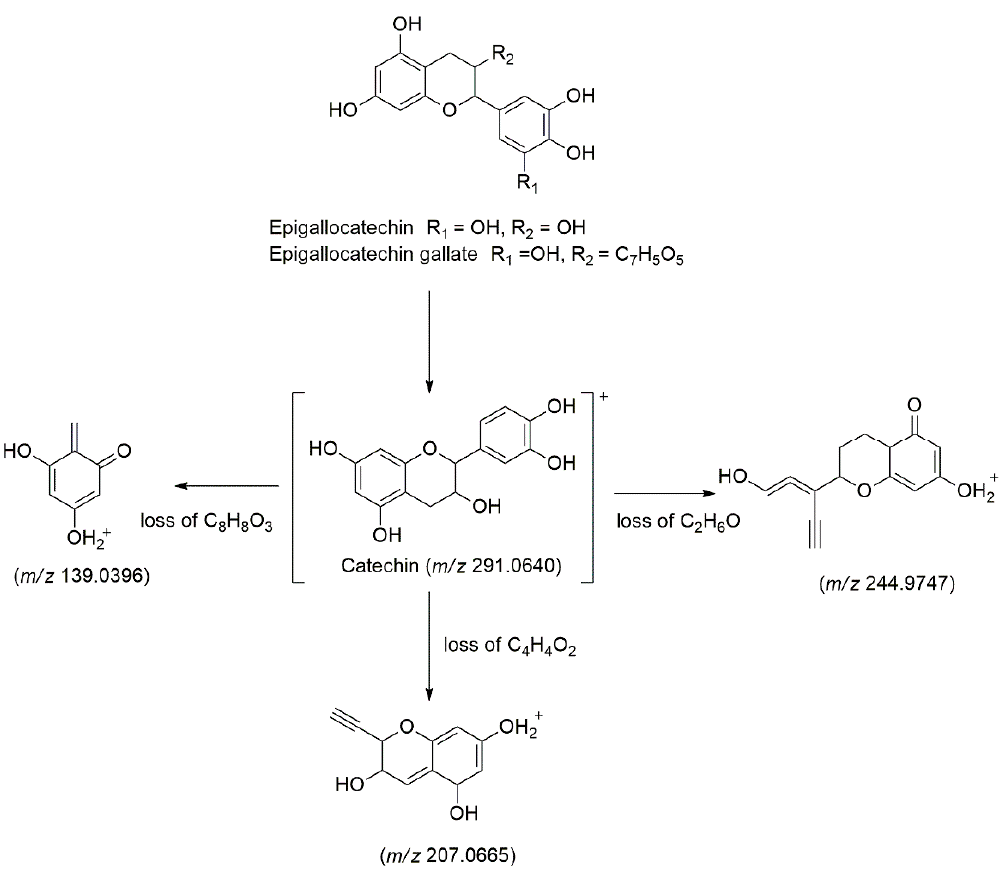
Figure 2. The main fragmentation pathways of the catechin derivatives.